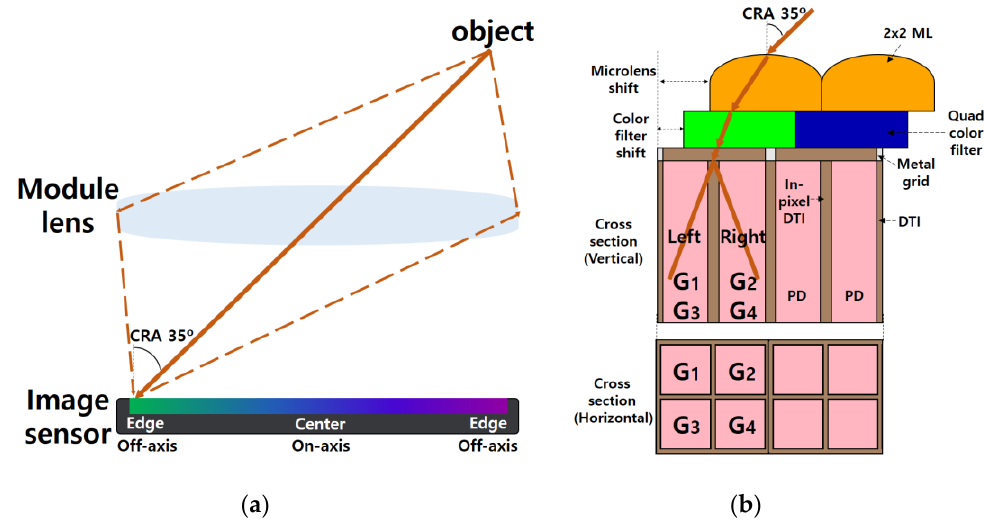
Figure 1. Schematic diagram of ( a ) the module lens and the image sensor, and ( b ) the cross sections of off-axis pixel at CRA 35°.